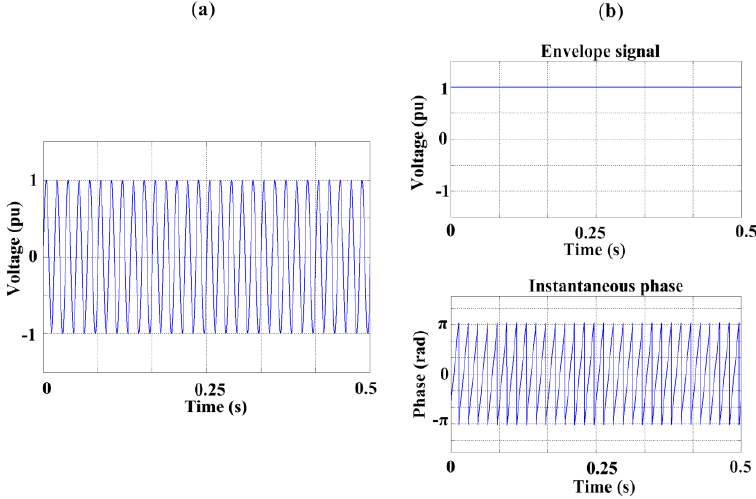
Figure 1. Hilbert Transform. ( a ) Sinusoidal waveform; ( b ) Hilbert Transform results.